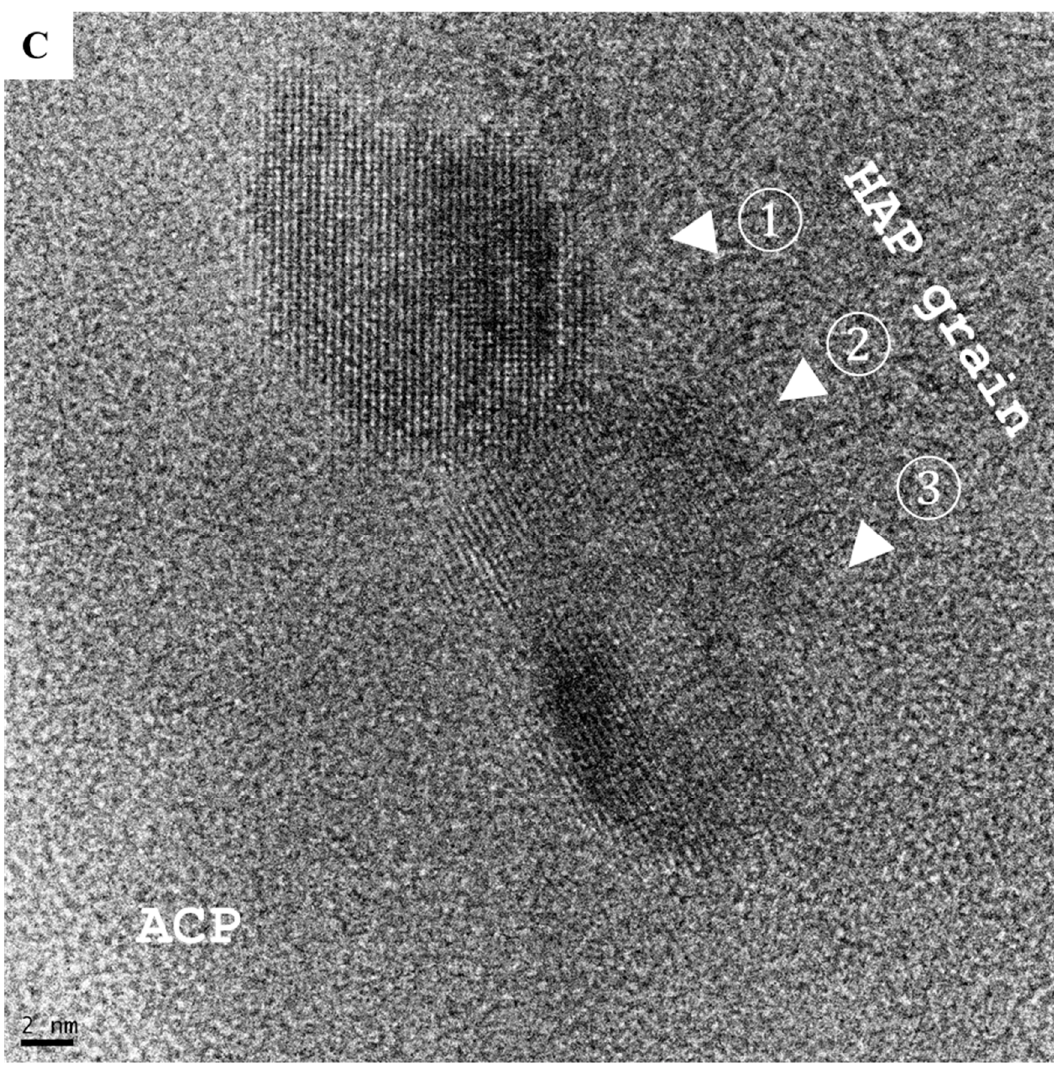
Figure 5. The development of hydroxyapatite (HAP). ( A ) Amorphous calcium phosphate (ACP) coiling (yellow arrows) was a remarkable precrystalline stage that formed polycrystalline masses (PC, in yellow circle). ( B ) Primary crystallization events occurred at the center of the coiling polycrystalline mass (yellow arrows) and resulted in 5–10 nm focus with the crystallographic texture of HAP (hollow arrows; scale bar = 5 nm). ( C ) Primary crystallization triggered a chain reaction that expanded HAP to crystallite grains (white arrows and numbers discrete HAP crystallites; scale bar = 2 nm).